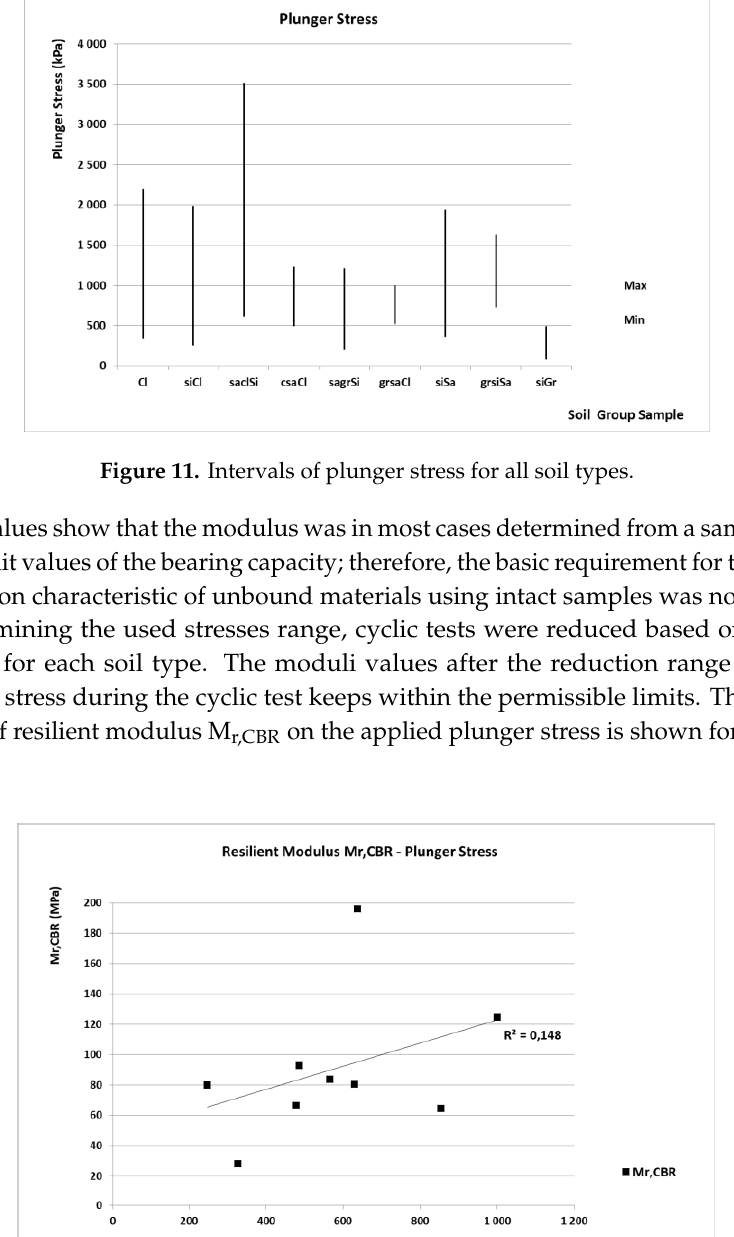
Figure 12. Dependence of the mean values of resilient modulus M r,CBR on the applied plunger stress.